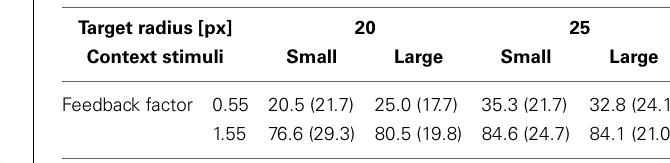
target context and feedback factor in Experiment 2.